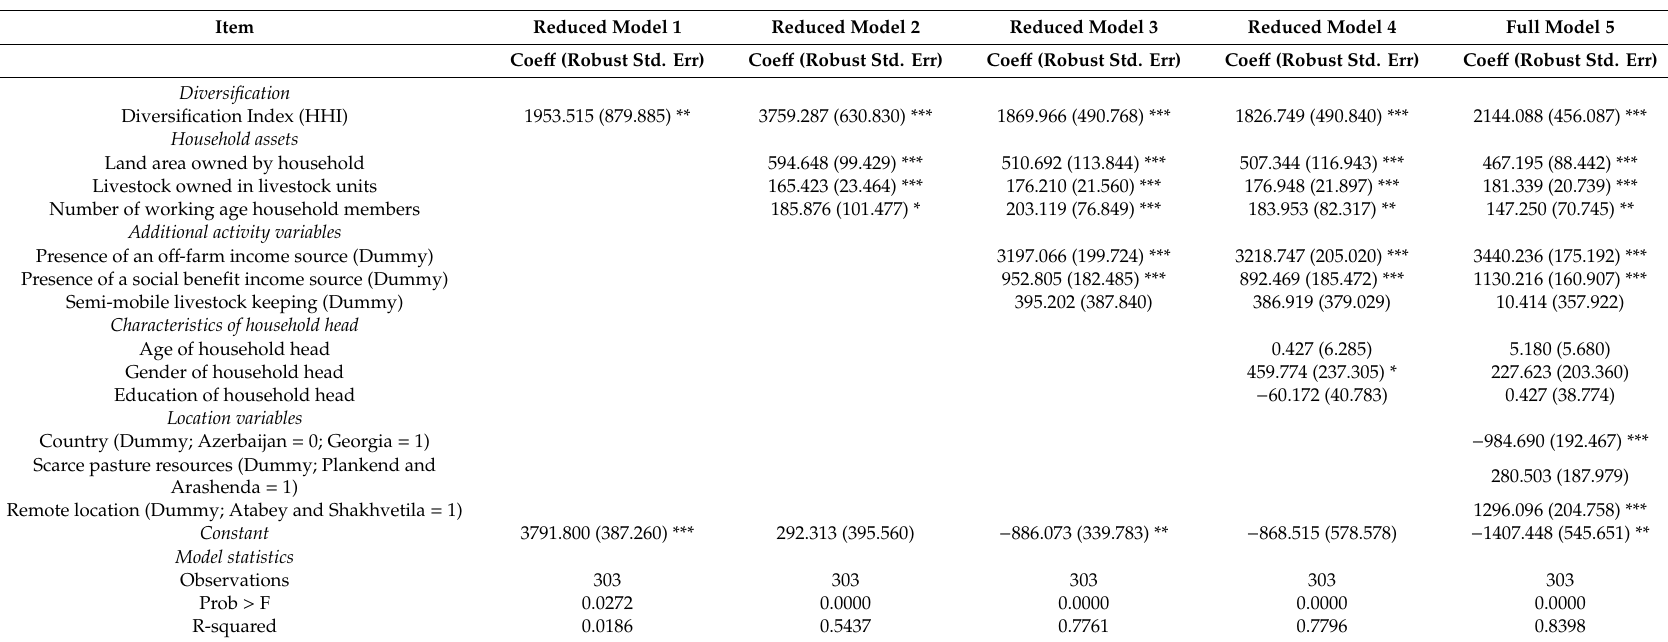
Table 6. Multiple linear regression models (OLS) with robust standard errors of influential variables on household